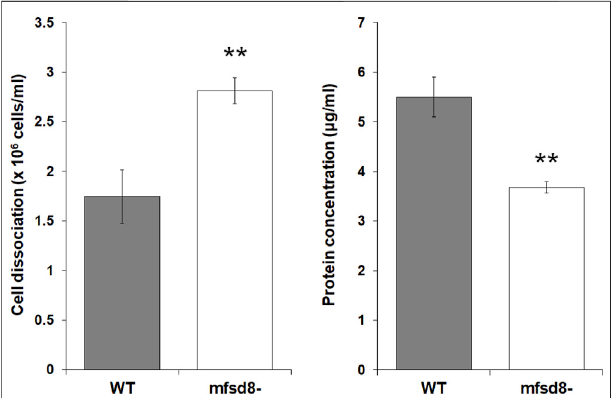
cells. WT cells were submerged in KK2 buffer for 2 h, after which time, the conditioned buffer (CB) of starving WT cells was collected and added to mfsd8 − cells at the onset of starvation. Images are representative of nine independent experiments. Scale bar = 250 μ m.